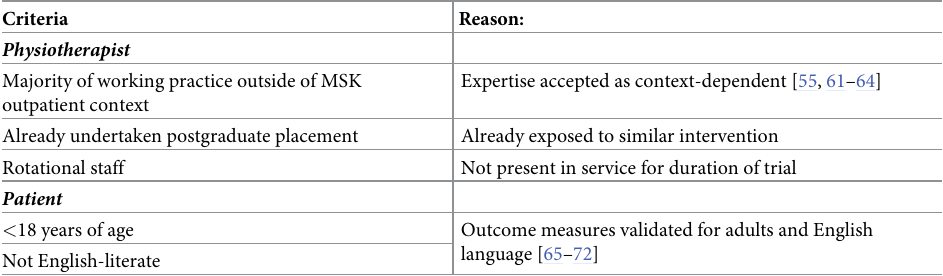
Table 2. Exclusion criteria.